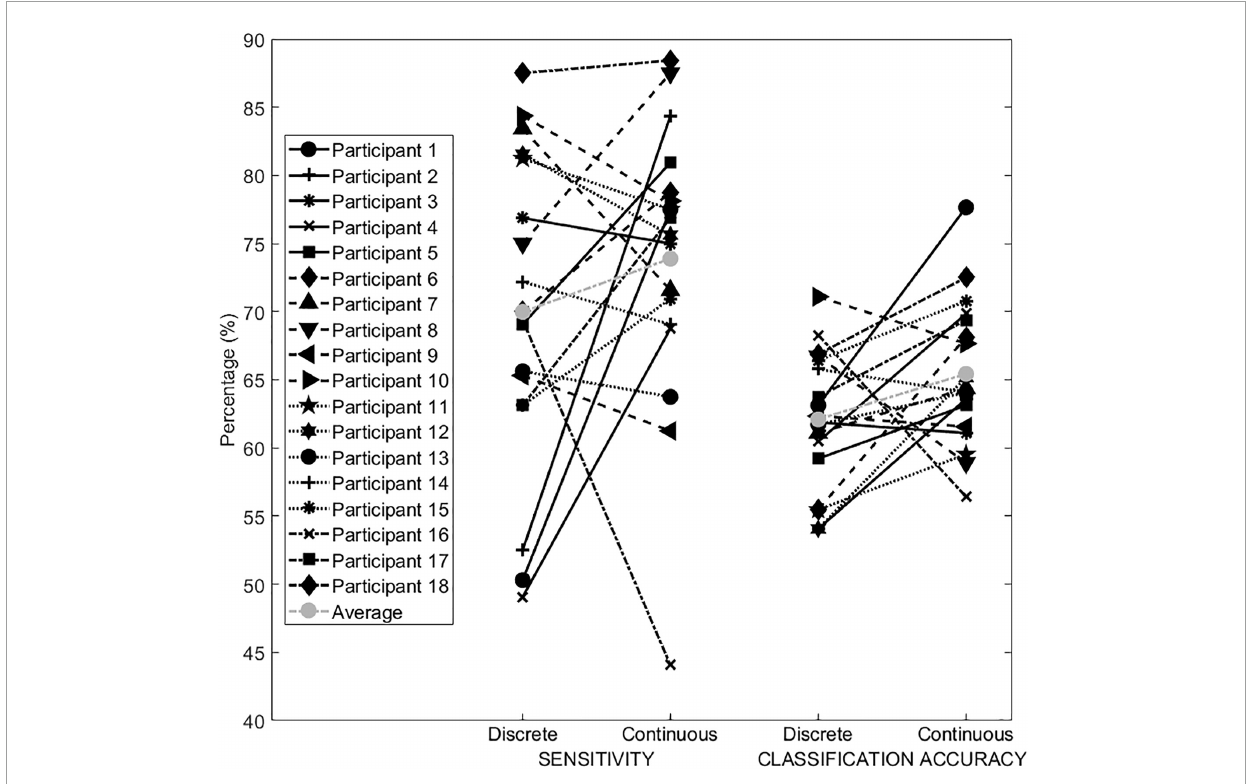
FIGURE3 Participants’ mean Sens (left) and CA (right) achieved with the discrete and the continuous